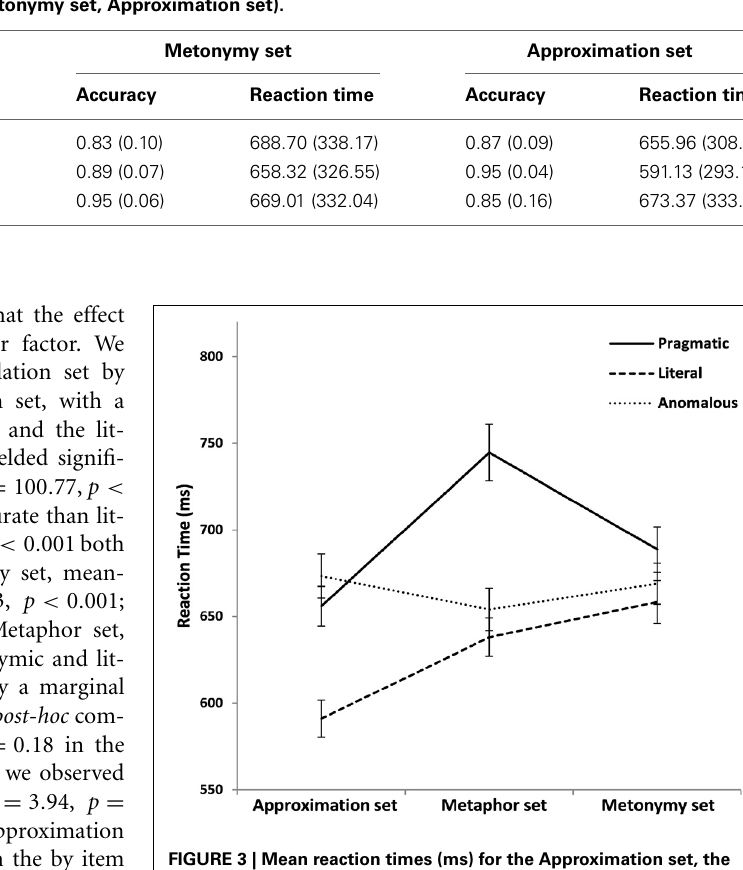
FIGURE 3 | Mean reaction times (ms) for the Approximation set, the Metaphor set, and the Metonymy set as a function of the meaning modulation factor. Pragmatic level is represented by the solid line, literal level by the dashed line, and anomalous level by the dotted line. Error bars indicate standard